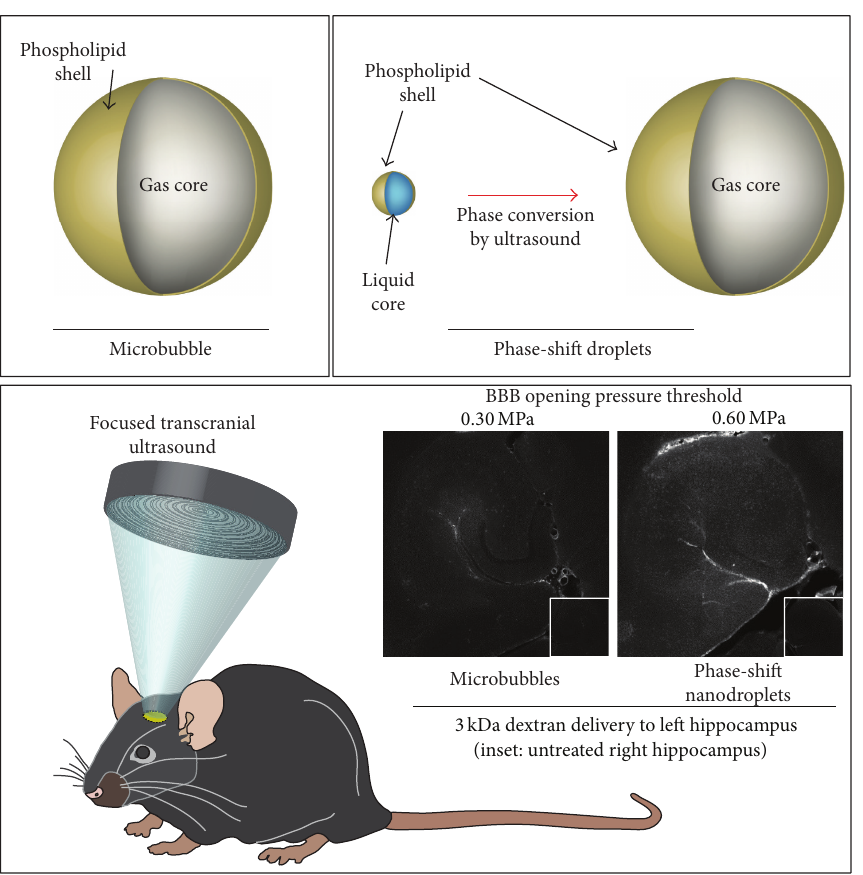
Figure 12: Blood-brain barrier opening with ultrasound contrast agents. When transcranial ultrasound energy is delivered to the left hippocampus of mice, blood-brain barrier permeability can be increased in the presence of both microbubbles and phase-shift droplets. When coinjected with 3kDa dextran, the fluorescence increase in histologic analysis of the hippocampus reveals successful permeabilization of the BBB as a function of peak negative pressure. Reprinted from [107], Copyright 2013, with permission from